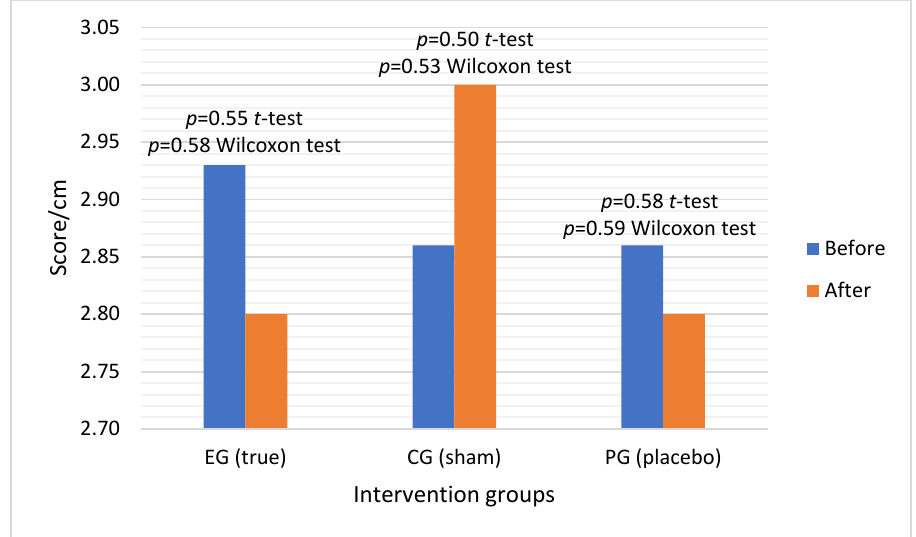
Figure 6. Average VAS results before and after true, sham, and placebo interventions.